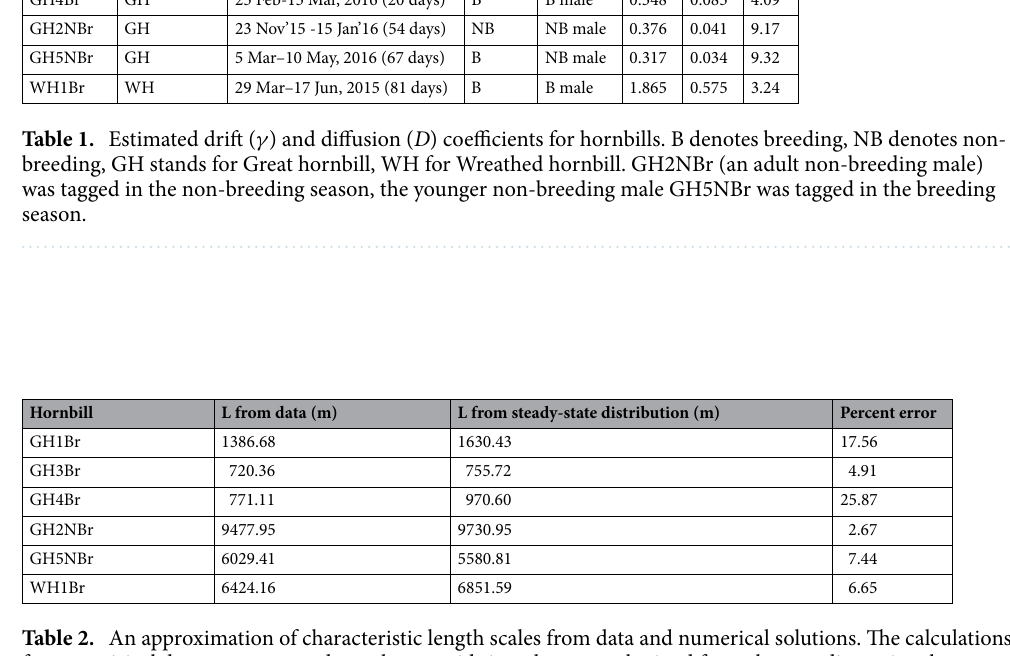
Table 2. An approximation of characteristic length scales from data and numerical solutions. The calculations from empirical data were executed over larger grid sizes that were obtained from the two-dimensional histograms of location